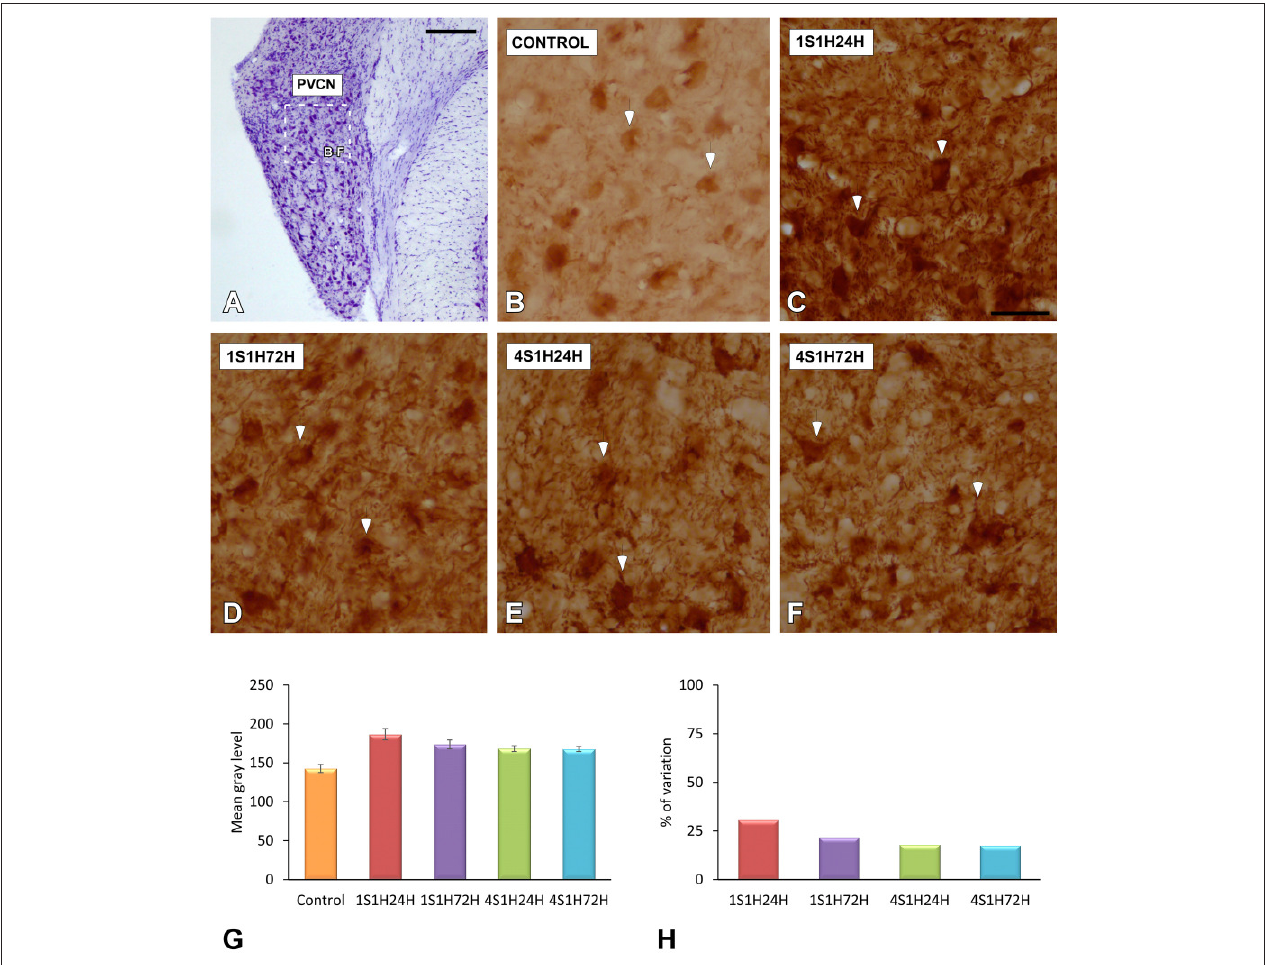
FIGURE 9 | Digitized images illustrating CR immunostaining in the PVCN in control and experimental Wistar rats. Similar to that in the AVCN, CR levels in both neurons and neuropil were augmented in all the experimental conditions (arrows in C–F ) when compared to control rats (arrows in B ). Bar graphs show the mean gray level of CR immunostaining (G) and the percentage of variation (H) in the experimental conditions with respect to control. The square box in (A) indicates the approximate location of the high-magnification images shown in (B–F) . Scale bars represent 250 µ m in (A) , and 50 µ m in (C)